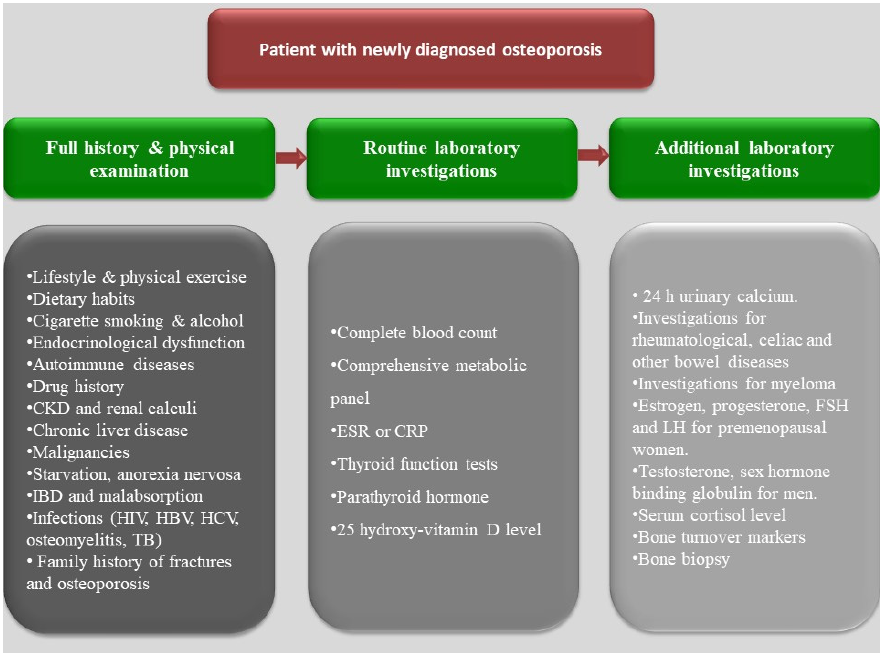
Figure 2. Pragmatic diagnostic approach for newly diagnosed patients with osteoporosis. A system- atic approach for the analysis and detection of a secondary cause of osteoporosis is recommended for all patients with a new diagnosis of osteoporosis. A full history and physical examination fol- lowed by a routine laboratory investigation for the most common and simple underlying causes of osteoporosis are required for most cases. Some additional investigation may be considered after routine lab for the suspected cases. CKD, chronic kidney disease, CRP: C-reactive protein; ESR: erythrocyte sedimentation rate; IBD: inflammatory bowel diseases; HCV: hepatitis C virus; HBV: hepatitis B virus; HIV: human immunodeficiency virus; TB: tuberculosis; FSH: follicle stimulating hormone; LH: luteinizing hormone.